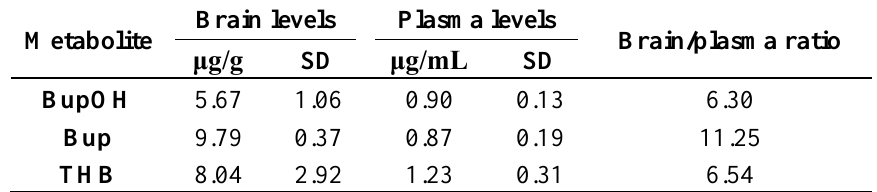
Table 2. The brain/plasma ratio of bupropion and metabolites in the guinea-pig 20 min post IP injection of 40 mg/Kg bupropion ( n =